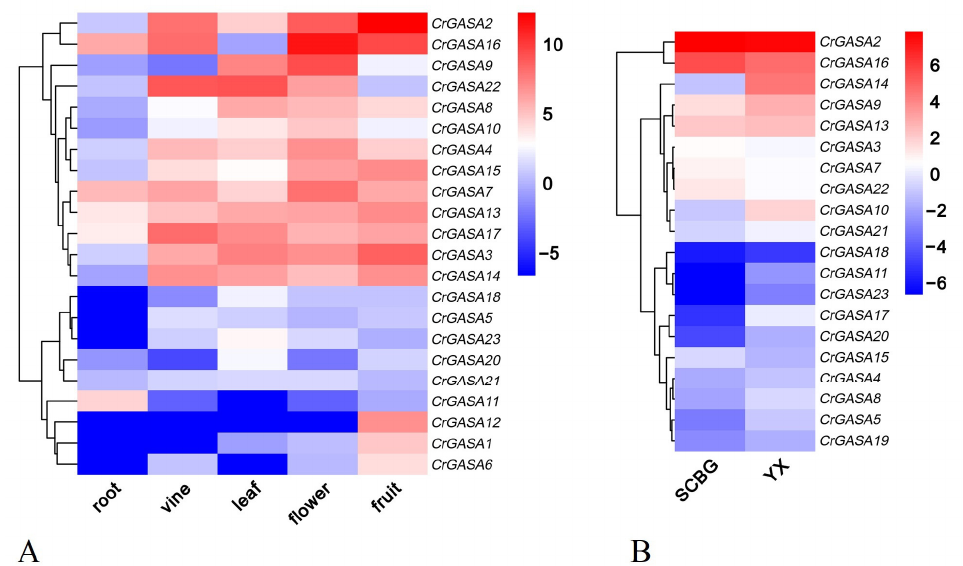
Figure 6. Heatmaps showing ( A ) the expression levels of the CrGASA s in the root, vine, leaf, flower bud, and young fruit of C. rosea plants and ( B ) expression differences of the CrGASA s in mature C. rosea leaves planted in the South China Botanical Garden (SCBG) and in Yongxing (YX) Island. The expression level of each gene is shown in FPKM (log2). Red denotes high expression levels, and blue denotes low expression levels. Data normalization was performed on the Oebiotech Cloud website (https://cloud.oebiotech.cn/task/detail/heatmap/ (accessed on 1 March 2022)).